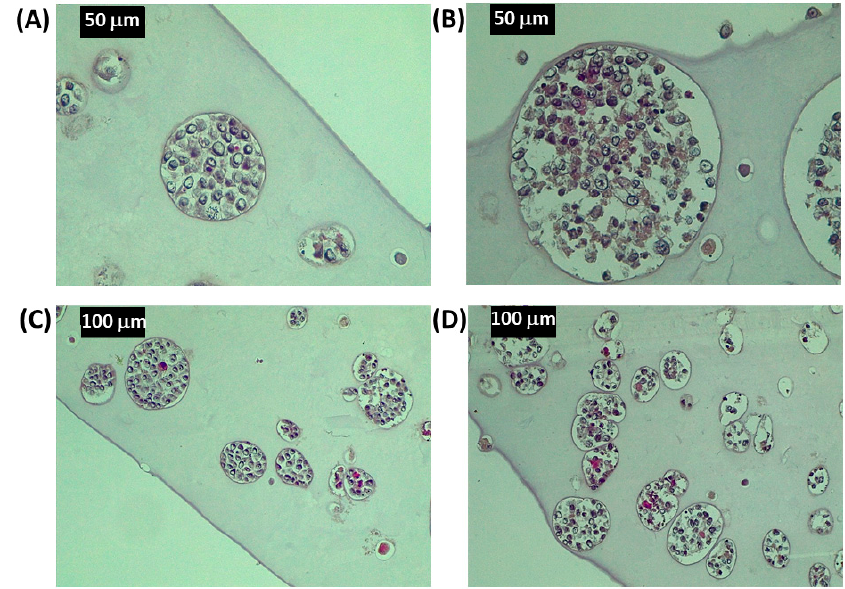
Figure 5. Histological images of HeLa spheroids in the 3D bioprinted alginate matrix. HE staining of HeLa spheroids in the alginate matrix after 11 ( A , C ) and 18 ( B , D ) days of culturing. Magnification factor: ( A , B ), 40×; ( C , D ), 20×.